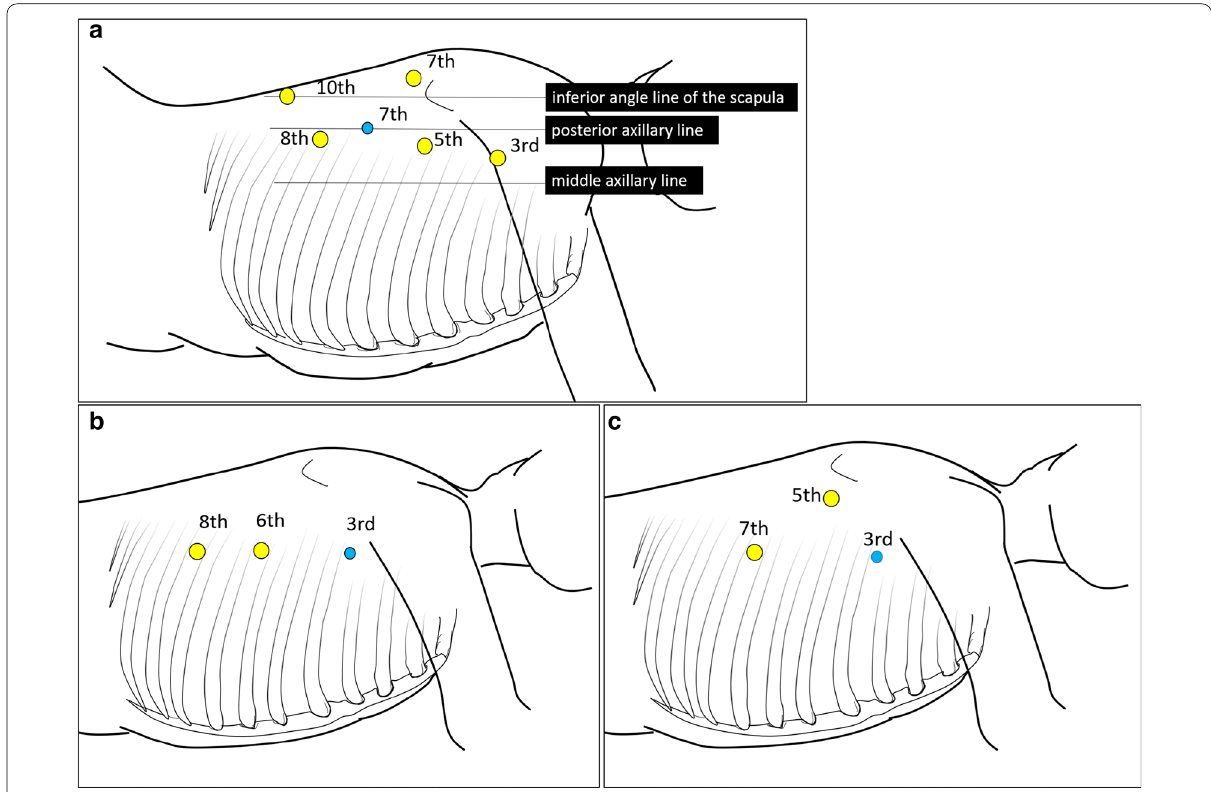
Fig. 6 Port arrangements. a Port placement in this case. Six ports were placed thoracoscopically. The yellow circle indicates the 5-mm port, and the blue circle indicates the 3-mm port. b Port placement in a pediatric patient with type A congenital esophageal atresia at our hospital. Three ports are placed thoracoscopically: one each at the 3rd, 6th, and 8th intercostal spaces at the posterior axillary line. c Port placement in a pediatric patient with type C congenital esophageal atresia at our hospital. Three ports are placed thoracoscopically: one at the 3rd intercostal space at the posterior axillary line, one at the 7 th intercostal space at the posterior axillary line, and one near the tip of the